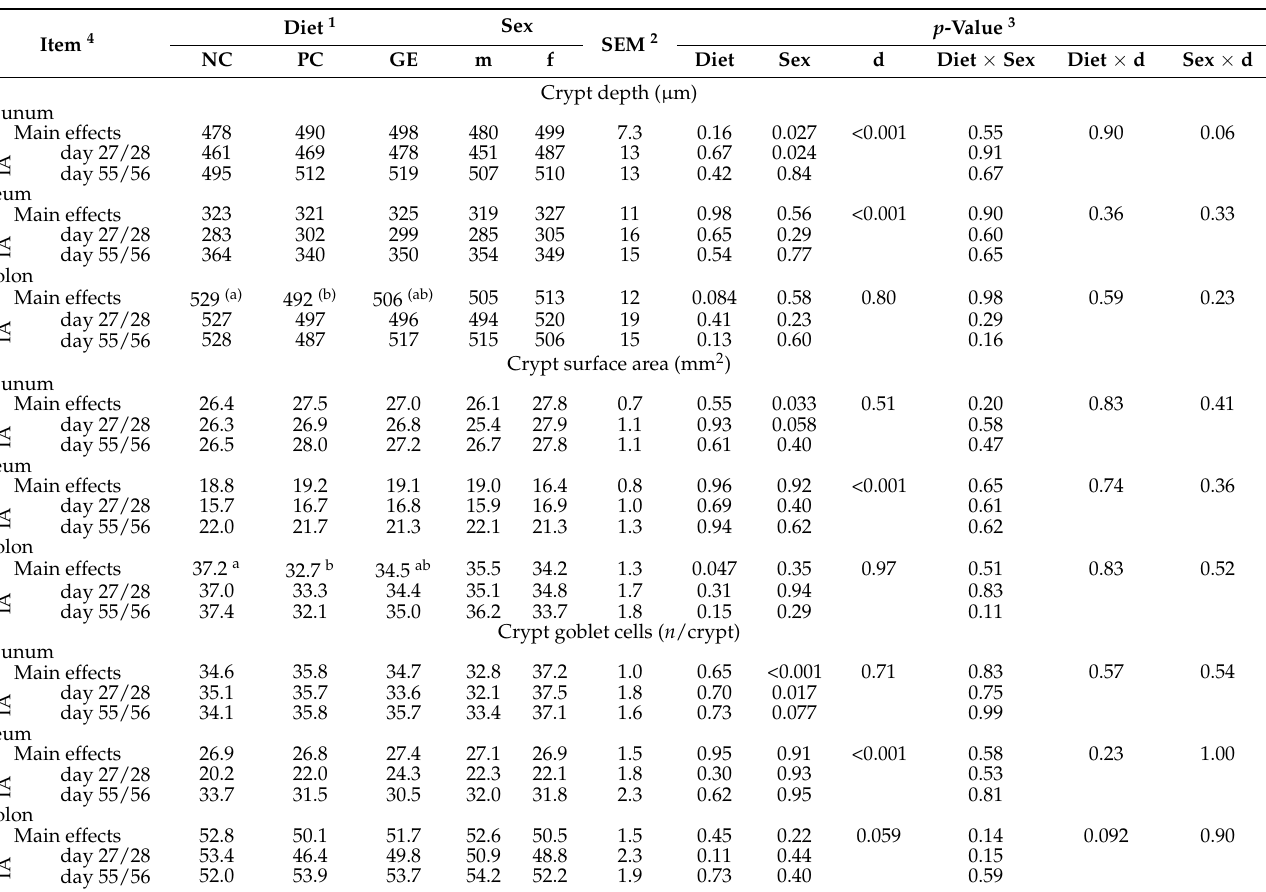
Table 3. Effect of dietary GE supplementation on intestinal crypt morphology of weaning piglets compared to NC and